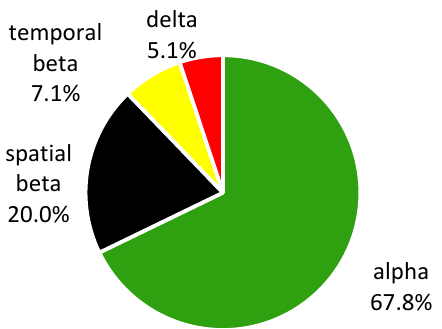
Figure 6. Partitioning of species richness of Romanian forests (epsilon diversity) into local diversity at the level of forest plots (alpha), species turnover among plots of the same forest type (spatial beta), species turnover among survey years of the same forest type (temporal beta), and the diversity at the level of forest types (delta).